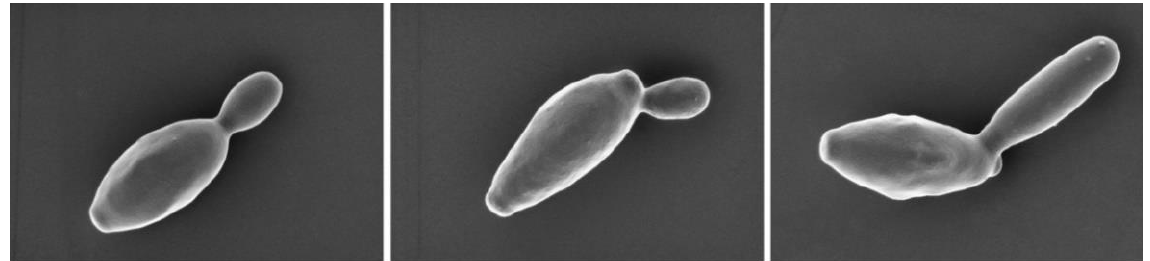
Figure 1. Scanning electron microscopy (SEM) images of Brettanomyces deamine kh3.